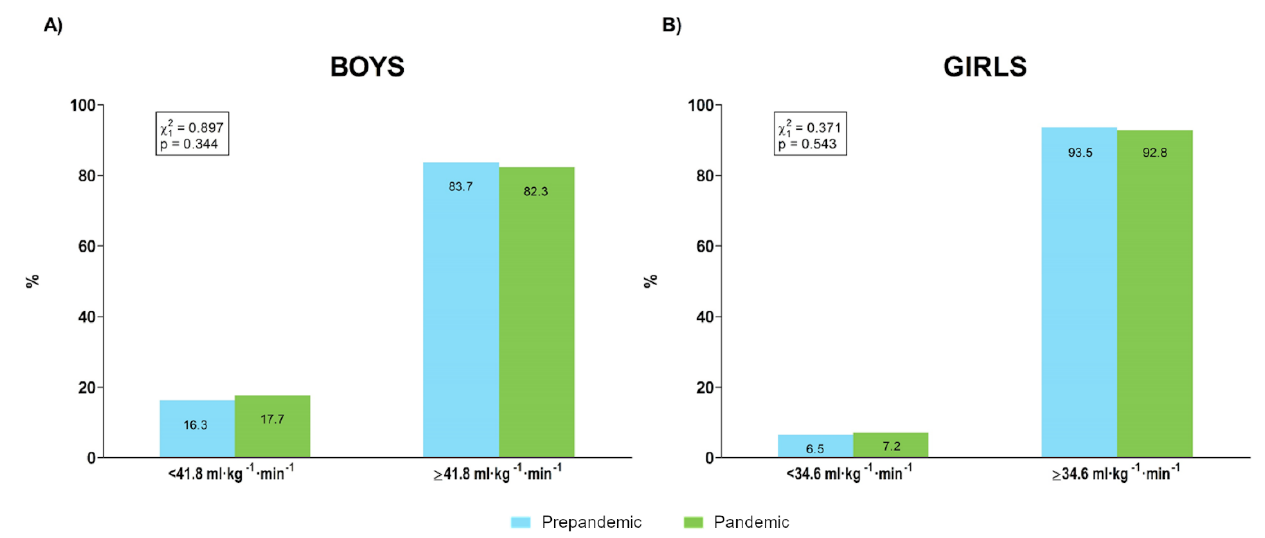
Figure 9. Percentages of boys ( A ) and girls ( B ) over and under cardiovascular risk 20 m shuttle run test performance cut points [35] before and during the pandemic.